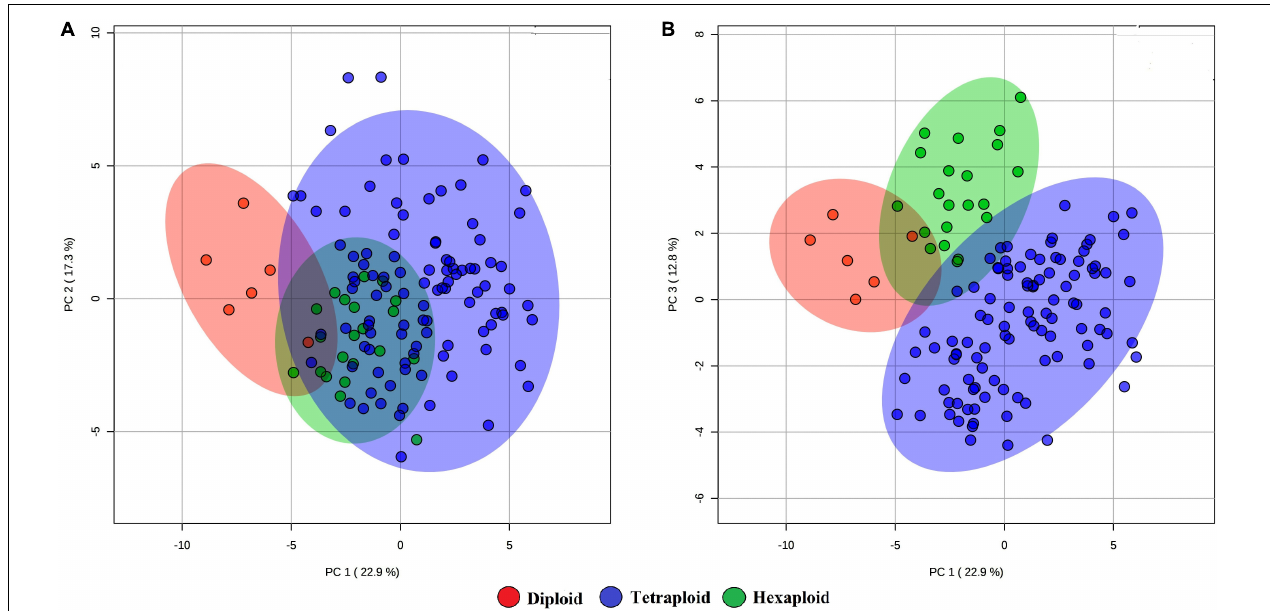
FIGURE 5 | PCA score plots of the first and second (A) and first and third (B) principal components. The data obtained from metabolites and fruit quality data of 128 blueberry accessions across three ploidy levels (diploid, tetraploid, and hexaploid).